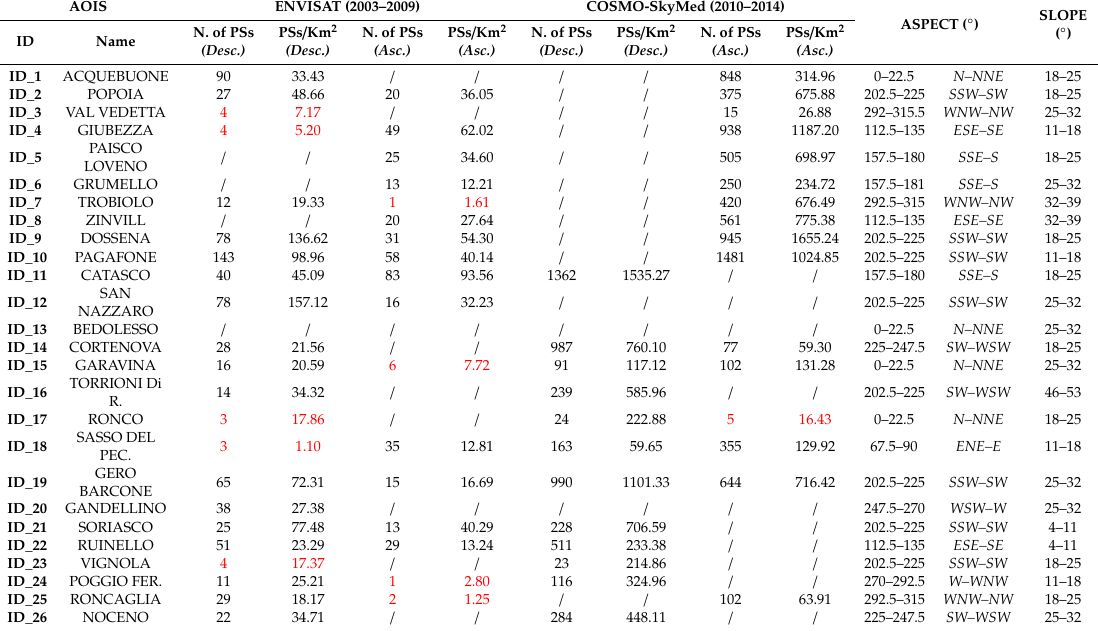
Table 2. Number of PSs and PSs density (PSs / Km 2 ) resulting from A-DInSAR analysis for each AOIs. Red values indicate N. of PSs < 10. The last two columns summarize the aspect and slope classes described in Figure 9 for each